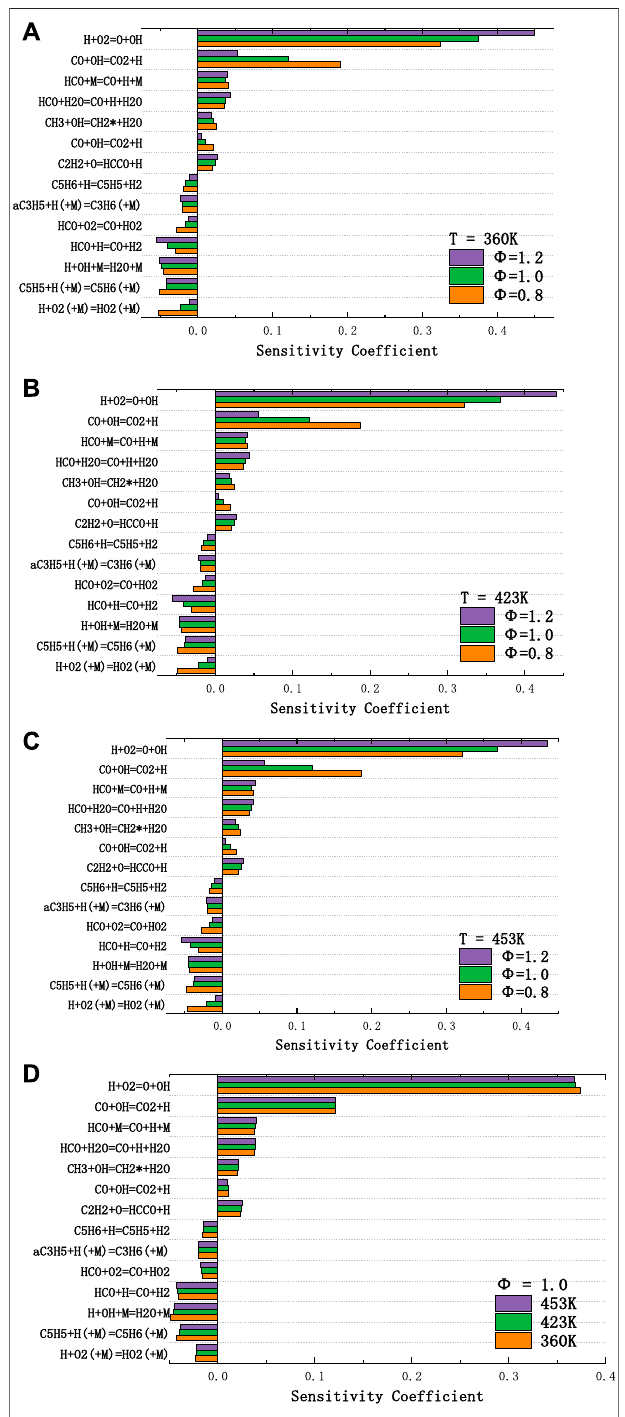
FIGURE6| Normalizedsensitivitycoef fi cientsinpredictinglaminar fl ame speed of JP-10/air fl ame for T= (A) 360 K, (B) 423 K, (C) 453 K, and (D) ϕ = 1.0, caculated with Hychem detailed